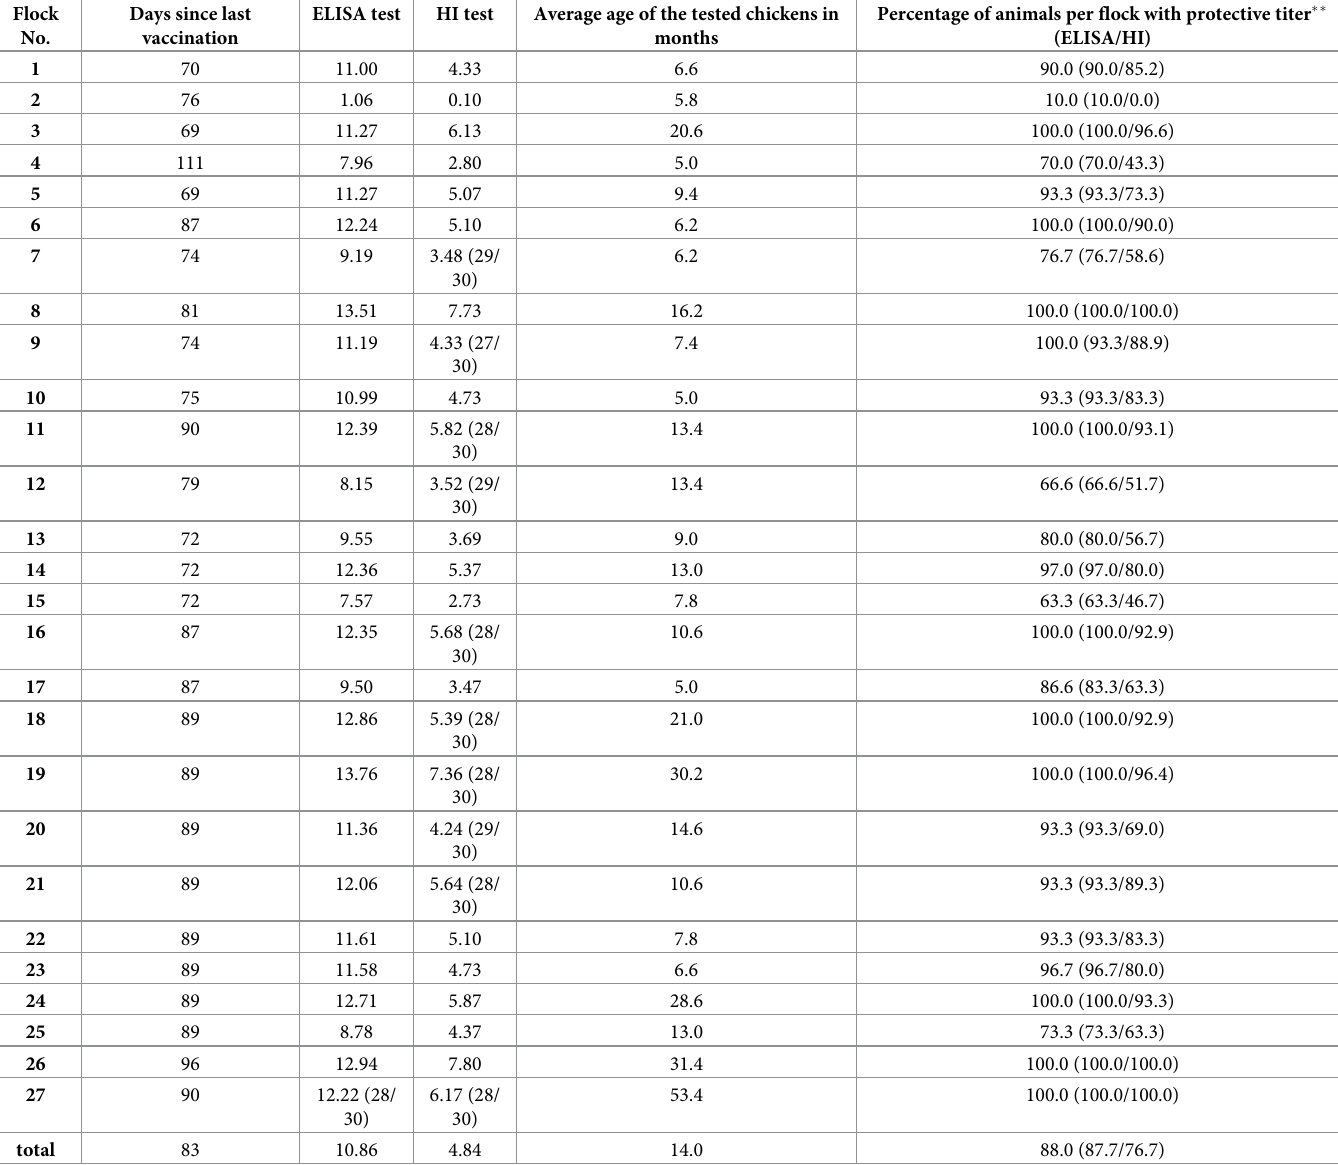
Table 3. Mean titer value of each flock in the ELISA test and HI test and percentage of animals with a protective titer per flock � . Flock